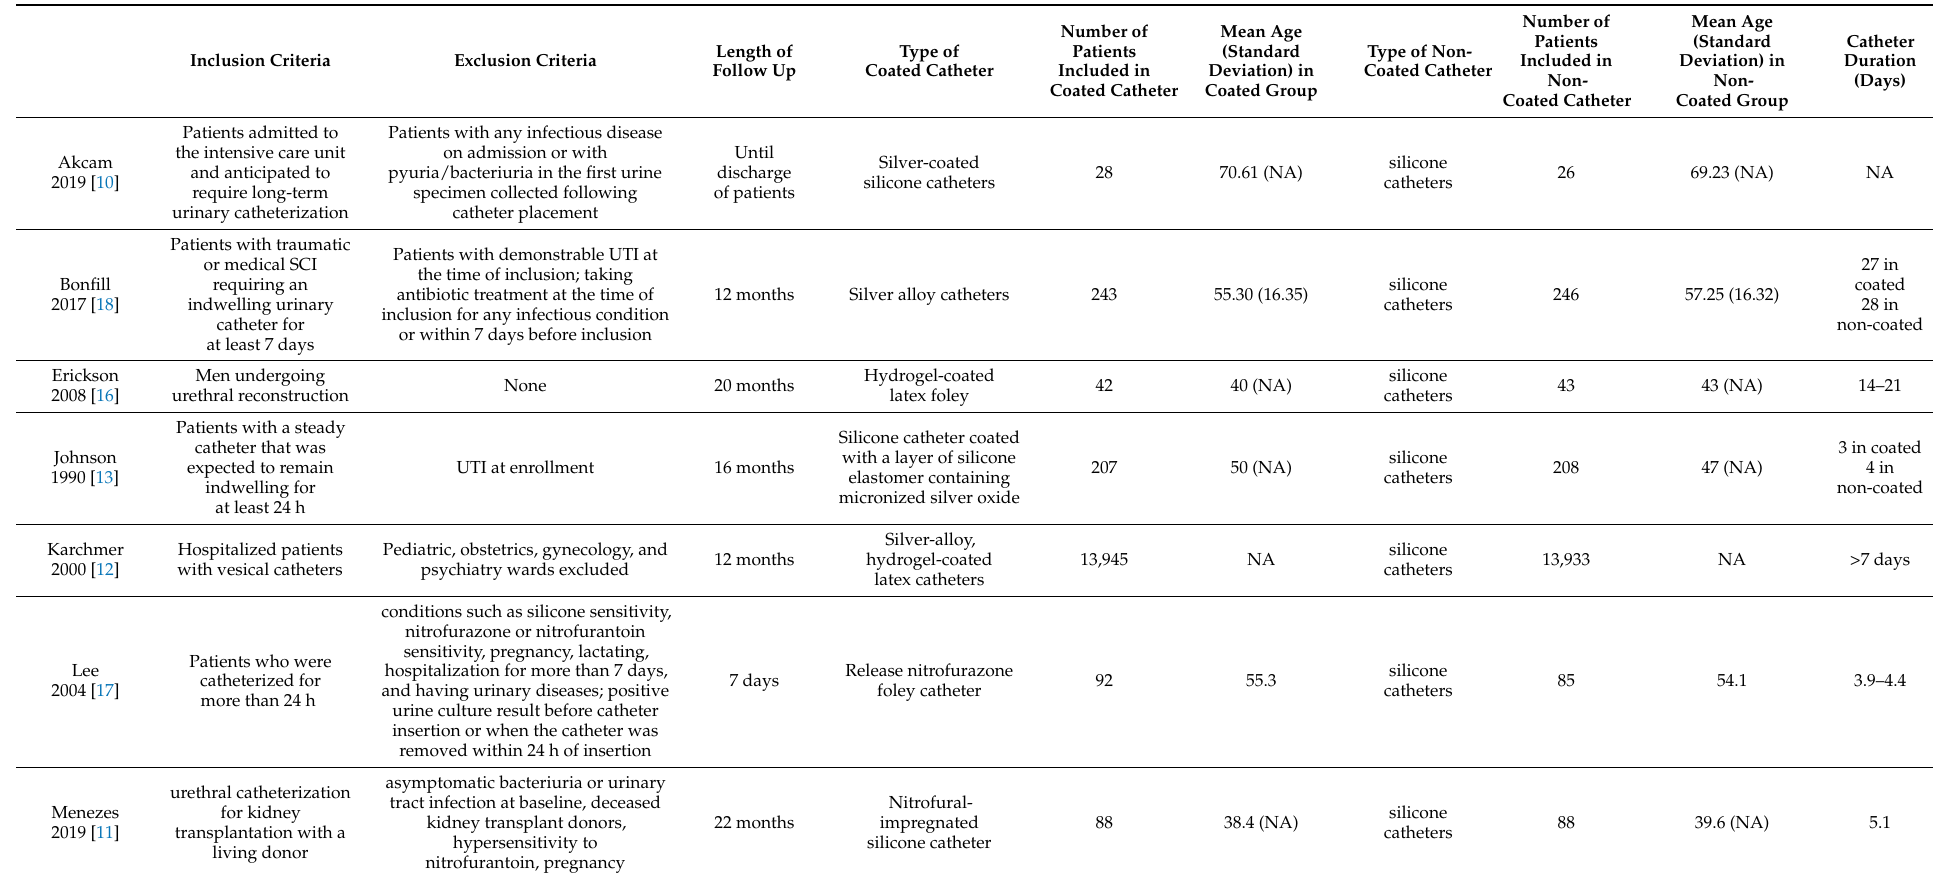
Table 1. Characteristics of the included studies. NA: not available. UTI: urinary tract infections. SCI : spinal cord